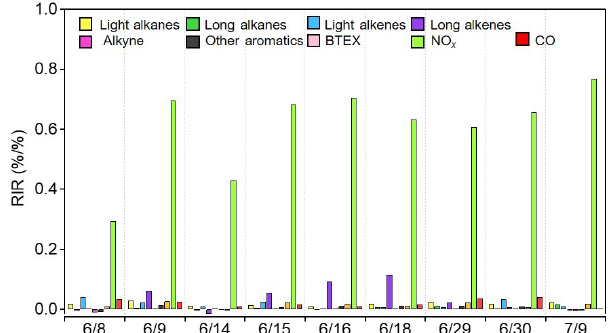
Figure 14. Model-calculated midday average (09:00–15:00LT) RIRs for the major O 3 precursor groups during the summertime O 3